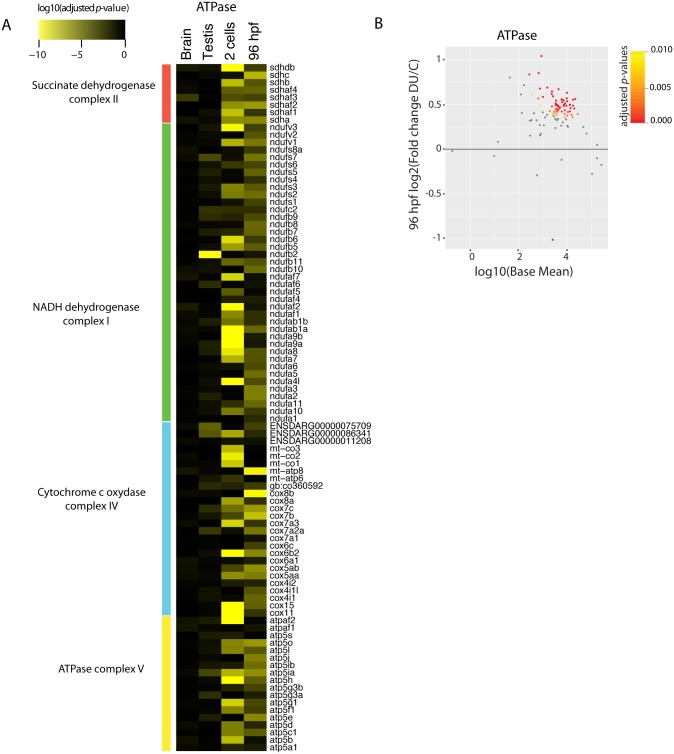
Expression analysis of electron transport chain complex genes in testis and brain of DU exposed fish and in their progeny at two-cells stage and 96 hpf.(A) Heatmap of adjusted p-values of genes involved in mitochondrial oxydo-reduction process (n = 101). The colour code displays the log10(adjusted p-value) from the differential expression analysis. (B) MA-plot focusing on the differential expression of the electron transport chain complex genes in the 96 hpf larvae (fold change as DU/C). Most of the genes are up-regulated in DU exposed larva.